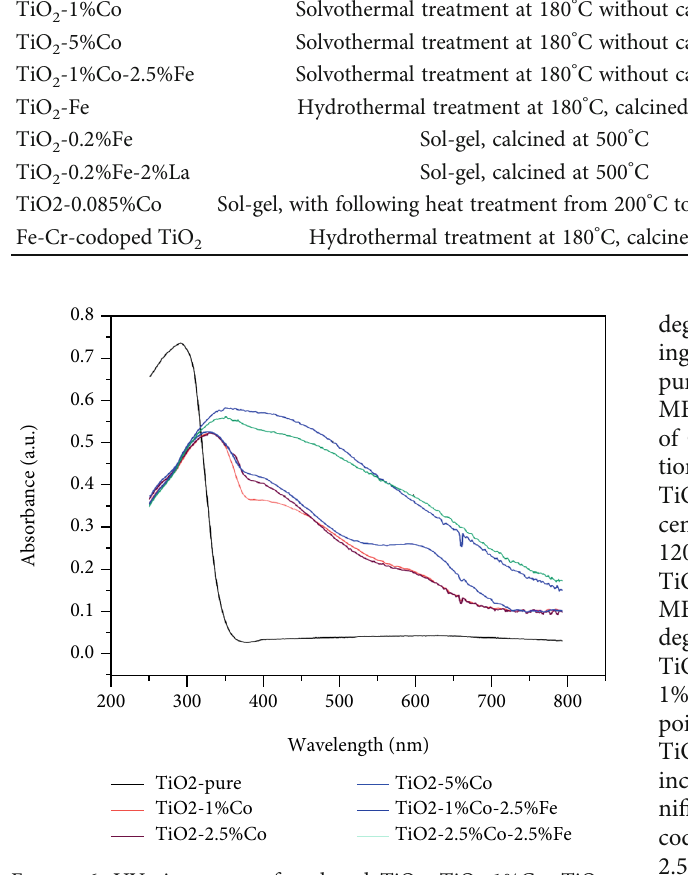
-1%Co-2.5%Fe, and TiO 2